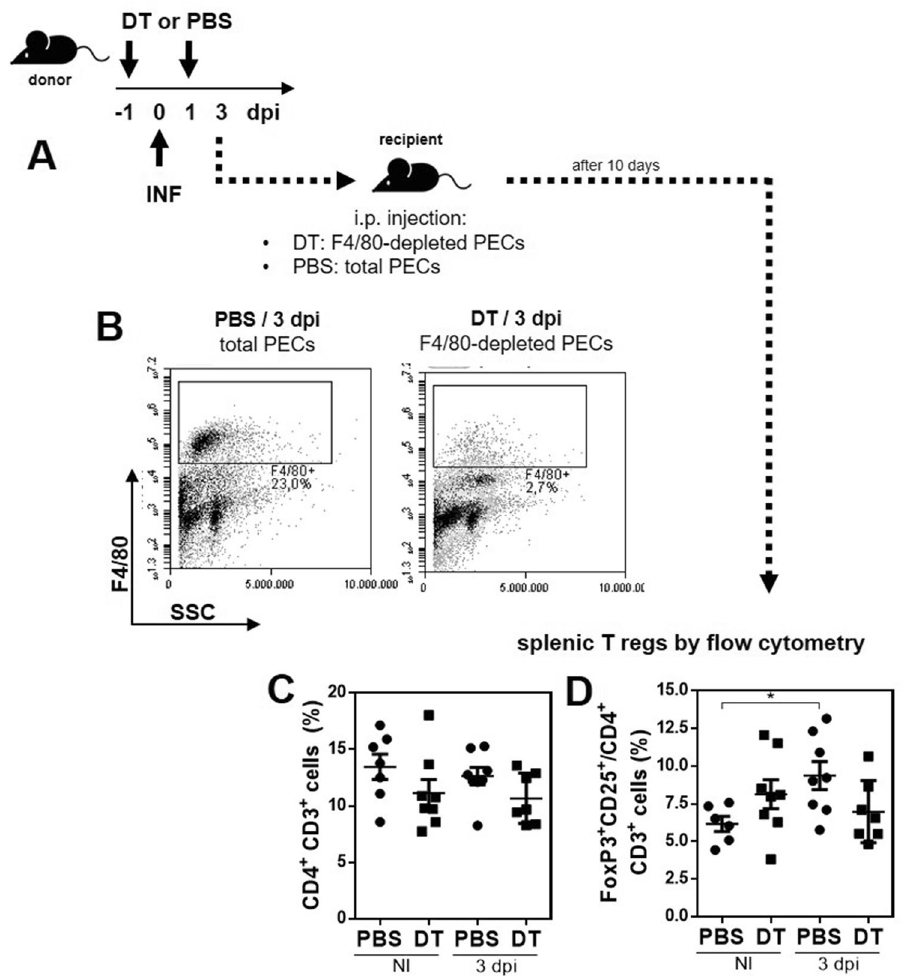
Figure 7. MGL2 + F4/80 + peritoneal cells induced by F. hepatica infection are necessary for Treg induction. ( A ) Adoptive transfer from infected MGL2-DTR mice to recipient non-infected mice. ( B ) F4/80 + peritoneal cell depletion with DT treatment after 3 dpi. Frequency and number of CD4 + CD3 + cells ( C ) and FoxP3 + CD25 + / CD4 + ( D ) cells in spleens from recipient mice determined by flow cytometry. A representative figure of two independent experiments is shown (± SEM, indicated by error bars). Asterisks indicate statistically significant differences (* p <